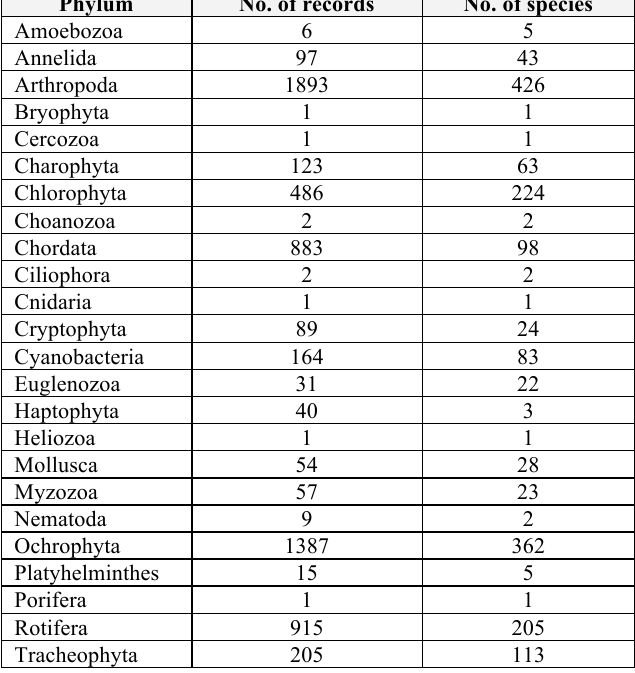
TABLE 2: Contribution of the different phyla to the composition of the data set. Phylum No. of